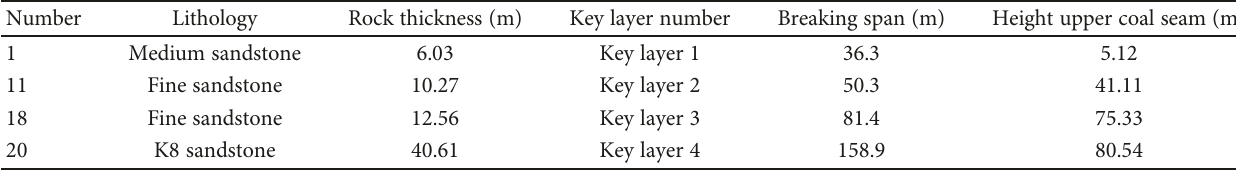
Table 3: Key layer parameter calculation